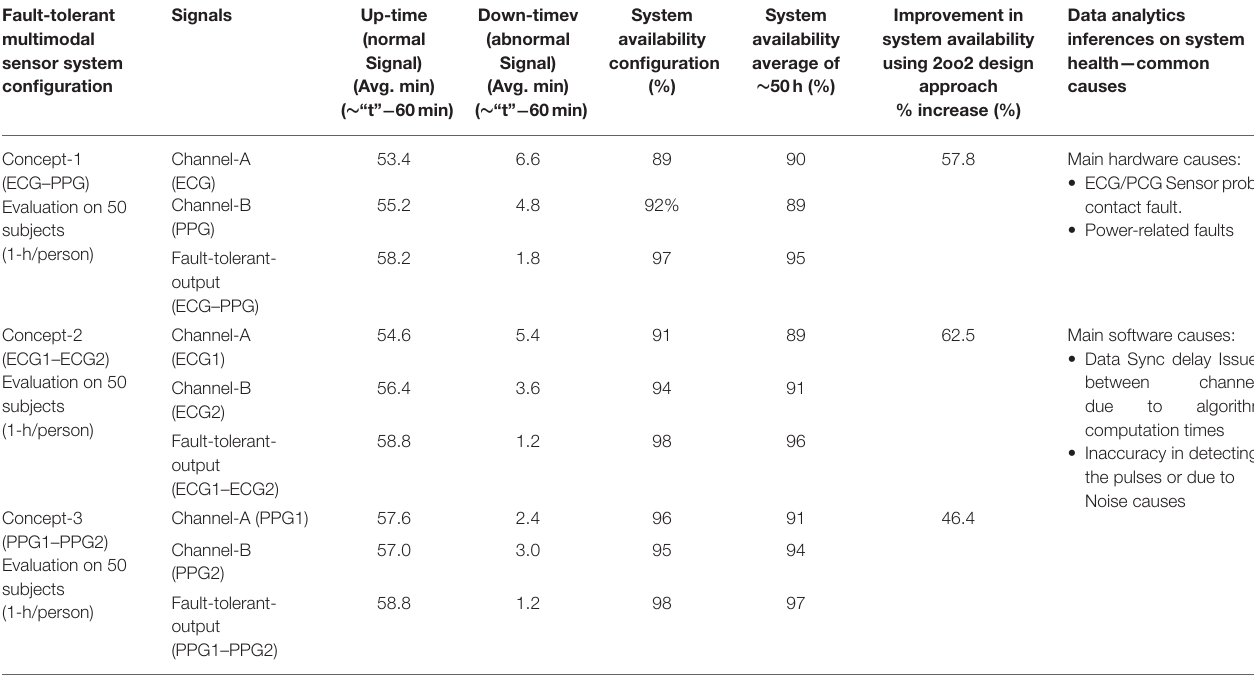
TABLE 4 | System availability results by configuring the fault-tolerant multimodal sensor system in 2oo2 system configuration mode. Fault-tolerant